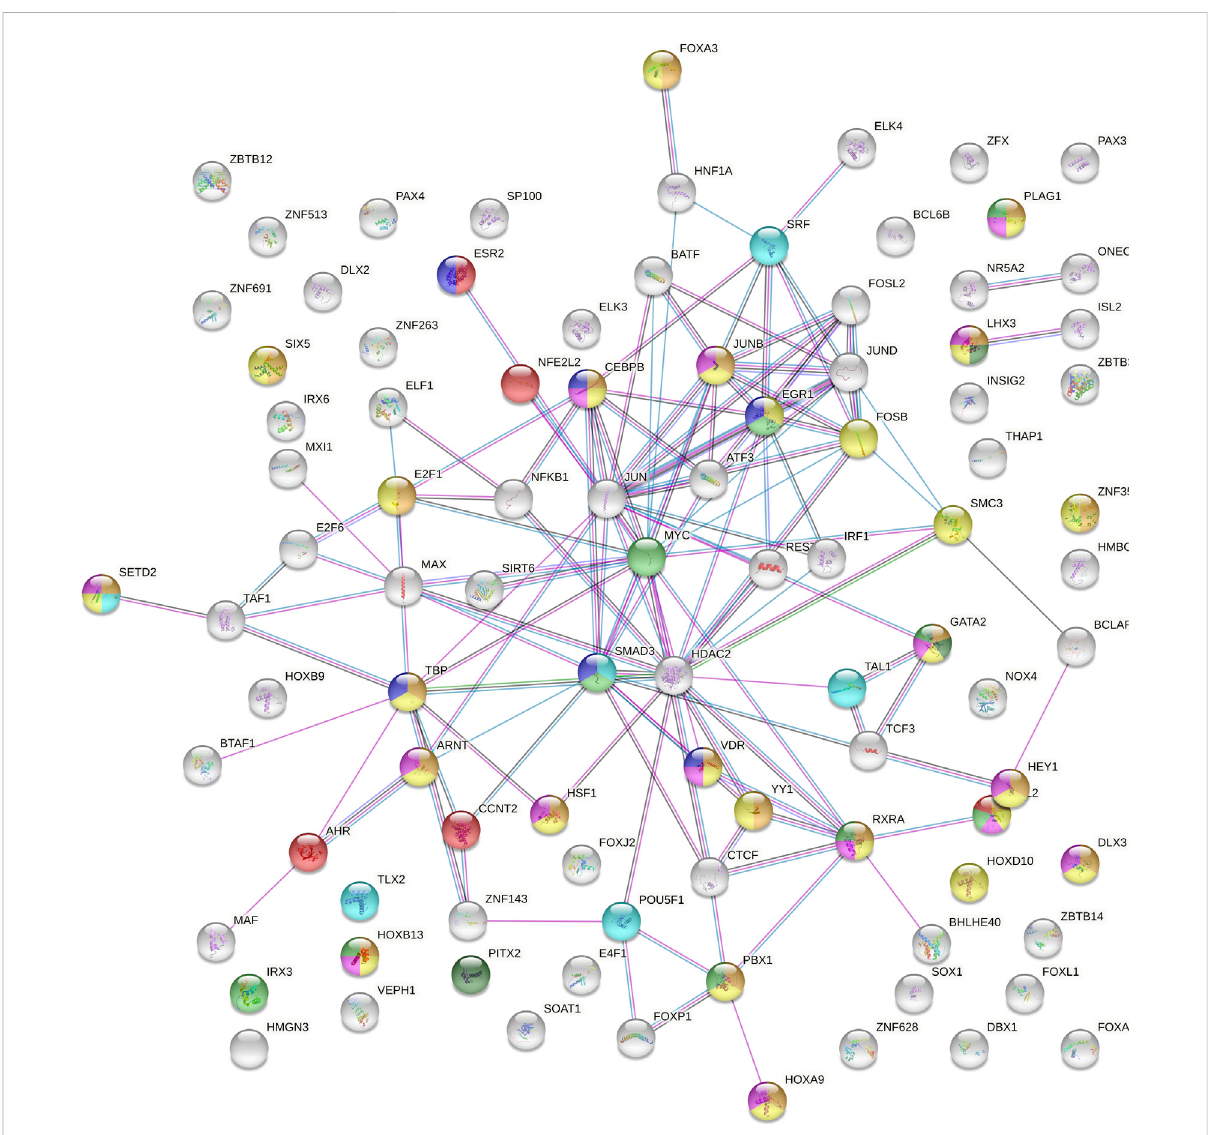
FIGURE 3 Protein-protein interaction network of the 122 transcription factors with predicted binding sites overlapping with TEX15 -rs1362912 and its proxies based on ChIP-seq experiments or protein weight matrix data. Blue lines indicate that the interaction is established from curated databases; pink lines indicate experimentally determined connections; green lines link neighbour genes; black lines represent co-expression; and grey lines correspond to proteins with homology. Bubble colour meaning: light blue, formation of primary germ layer; orange, developmental process involved in reproduction; yellow, reproductive process; pink, reproductive structure development; dark green, pituitary gland development; light green, urogenital system development; purple, ovarian infertility and red, male